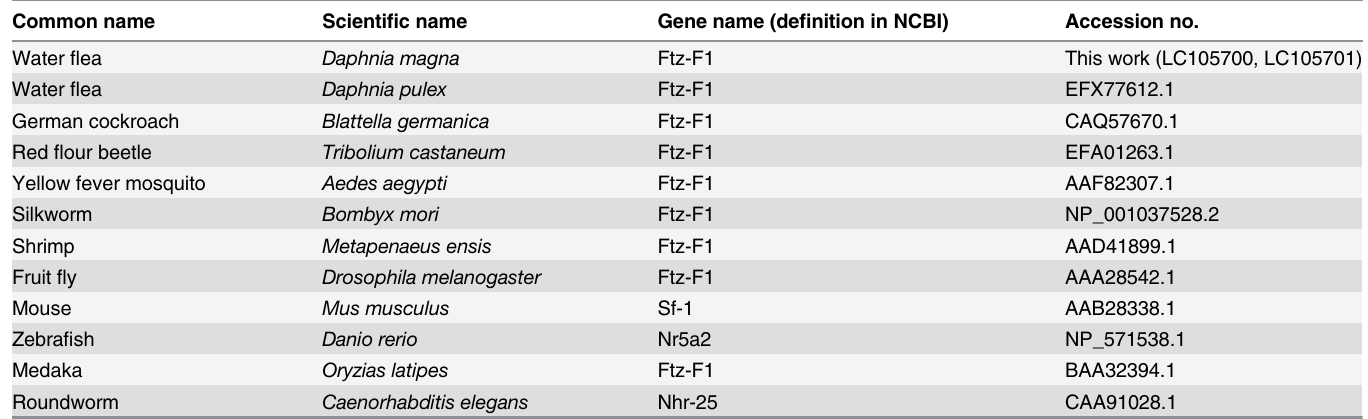
Table 1. Accession numbers of Ftz-F1 ortholog genes used in this